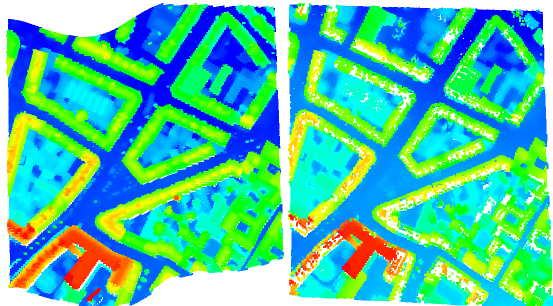
Figure 2: ALS dataset. Left: ALS 03 . Right: ALS 08 , colored with respect to the altitude (low (blue) → high (red)).